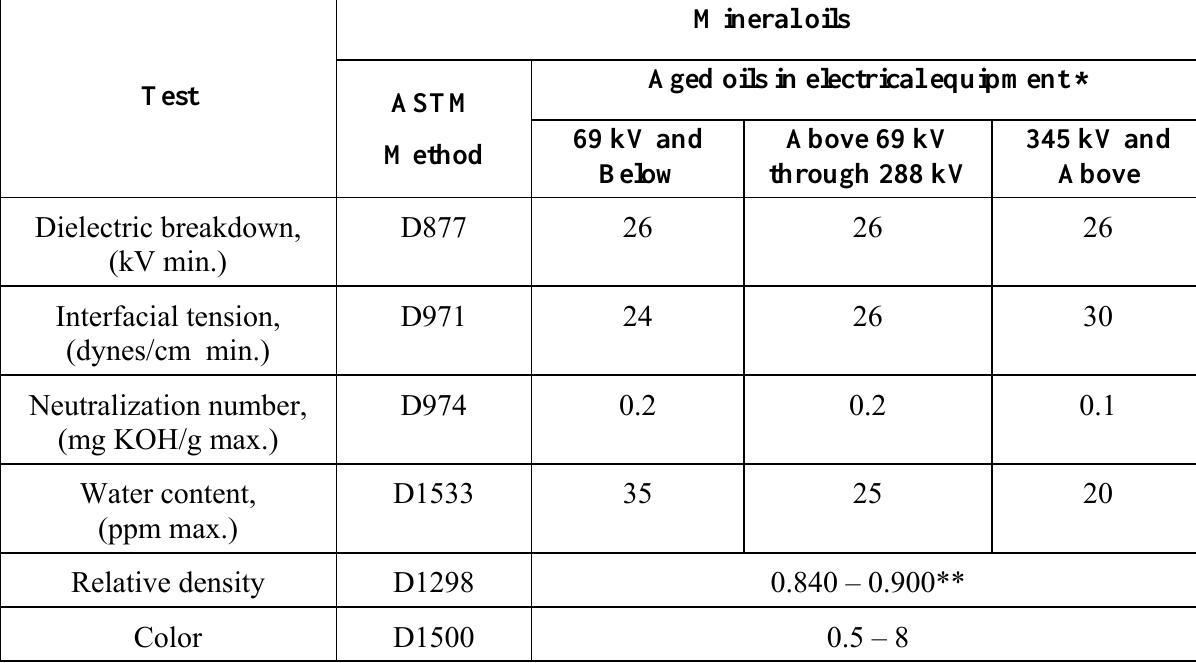
Table 1 . Physicochemical tests commonly performed on insulating transformer oils.